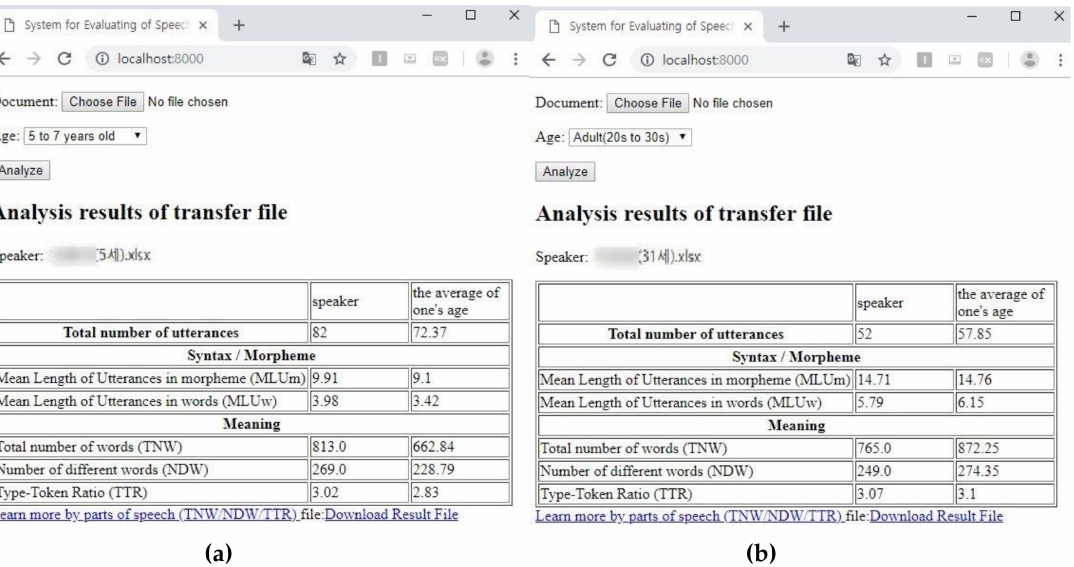
Figure 4. Result screen of our system. ( a ) shows the result of an interviewee having a higher language ability than his/her age. However, ( b ) shows the opposite case.